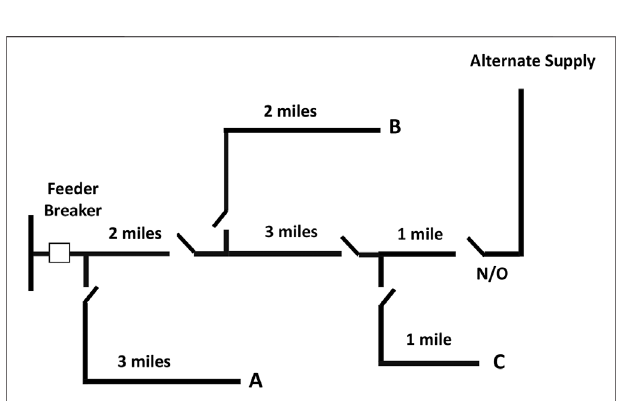
FIGURE4| Thestudiedradialdistributionsystem(BillintonandLi,2014).